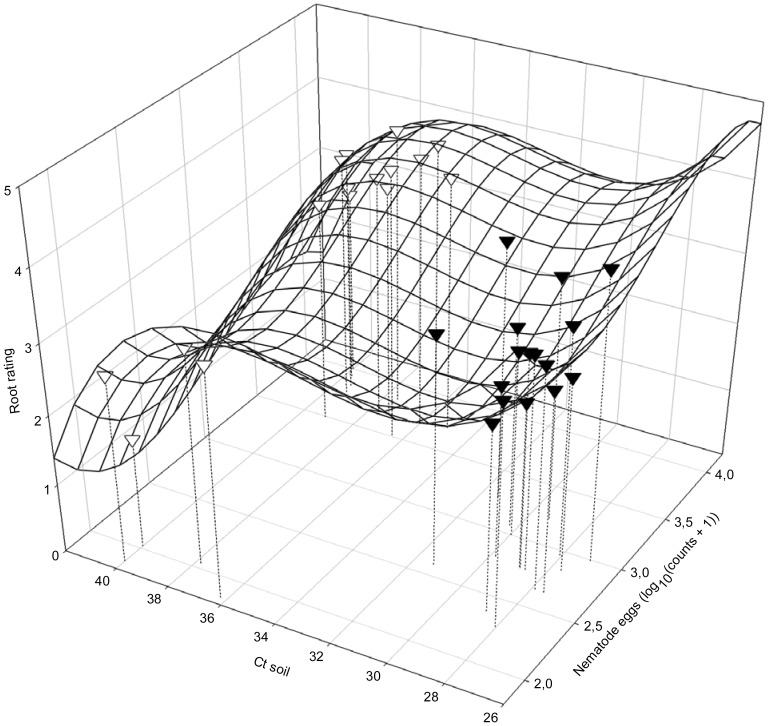
Root rating (RR) in relation to soil DNA of Fusarium virguliforme (Ct soil) and Heterodera glycines (LogPiH.glycines) at planting:RR  = 185.20784 −22.24517 LogPiH.glycines +7.50496 LogPiH.glycines
2 −0.80092 LogPiH.glycines s3 −14.74404 Ct soil +0.44699 Ct soil2 −0.00449 Ct soil3; R2 = 0.6289; Pi<0.01; Pa = 0.0509; Pb = 0.0504; Pc = 0.0552; Pd<0.01; Pe<0.01; Pf<0.01; ∇: 2006; ▾: 2007.